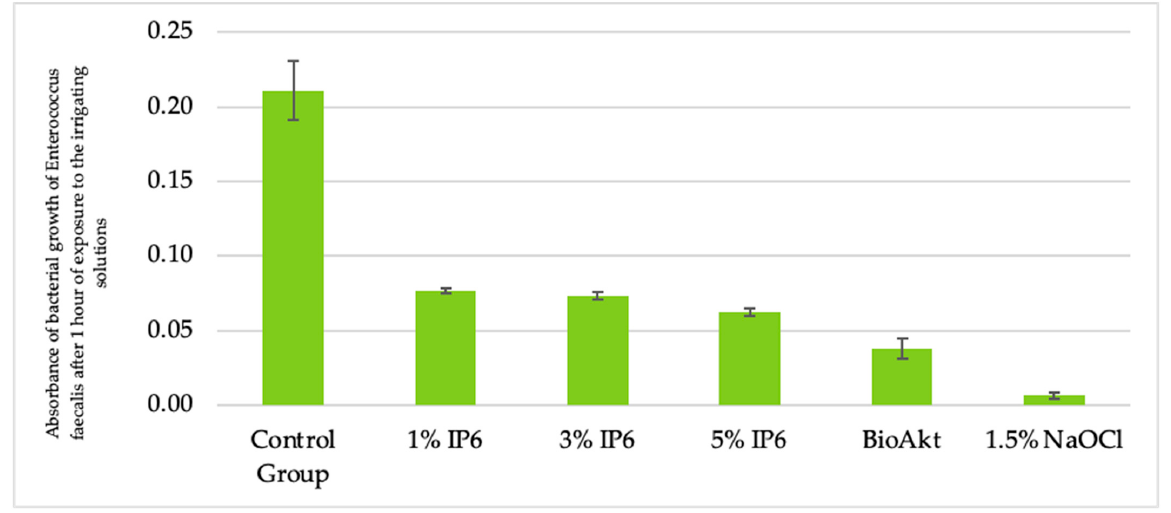
Figure 4. Effect of 1 h